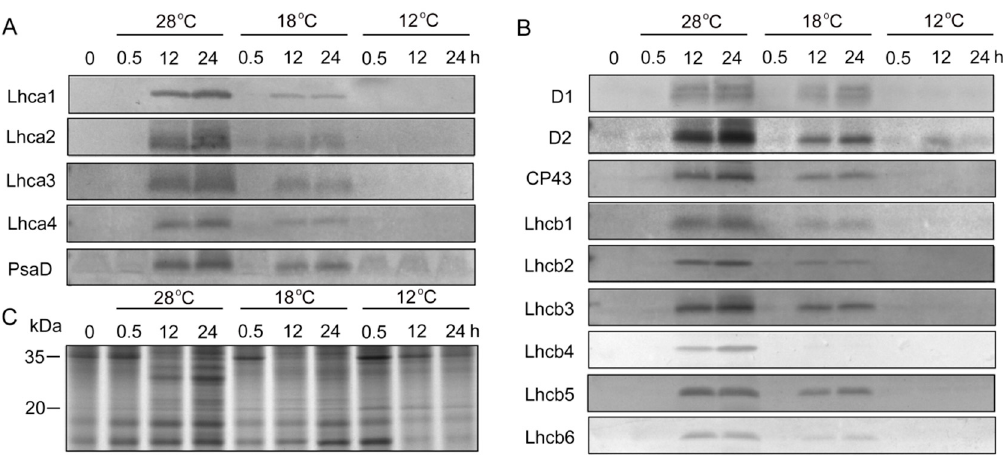
Figure 6. Immunoblot analysis of thylakoid proteins in control and chill-stressed rice seedlings. Six day old etiolated seedlings were treated with 18 ◦ C or 12 ◦ C chilling stress. Thylakoid proteins were isolated from control and chill-stressed seedlings after 0 h, 0.5 h, 12 h, and 48 h of greening. Immunoblot analyses were performed with antibodies specific for representative photosystem I (PSI) ( A ) and photosystem II (PSII) ( B ). The SDS–PAGE of 20 ug plastid protein stained by Coomassie blue ( C ).